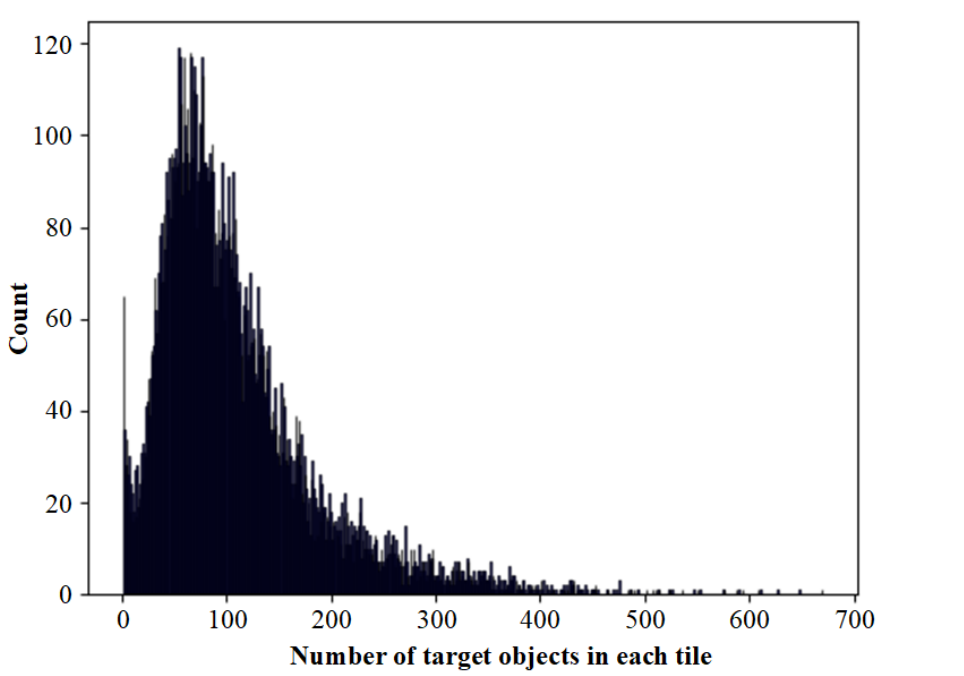
Figure 20. The distribution of the number of target objects in each tile of the